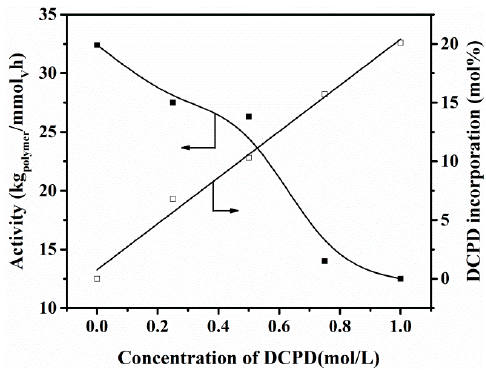
Figure 5. The influences of DCPD concentration on the catalytic activities of catalyst b and DCPD incorporations of the E/DCPD copolymers. Table 3. Ethylene/DCPD copolymerization by oxovanadium(V) complexes.